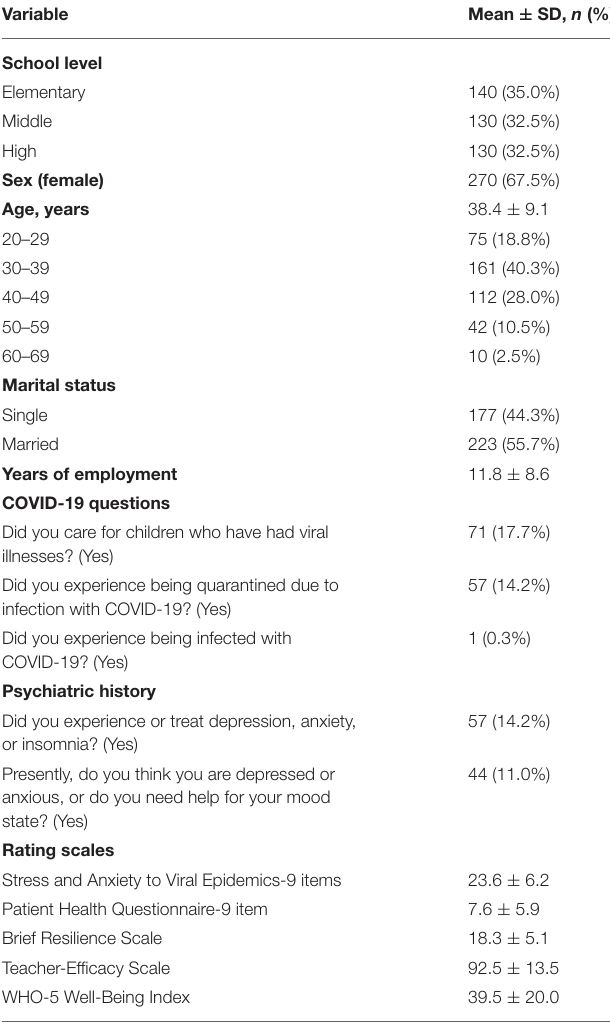
Table 5A ). The pathway from stress and anxiety to the viral epidemic (independent variable) through resilience